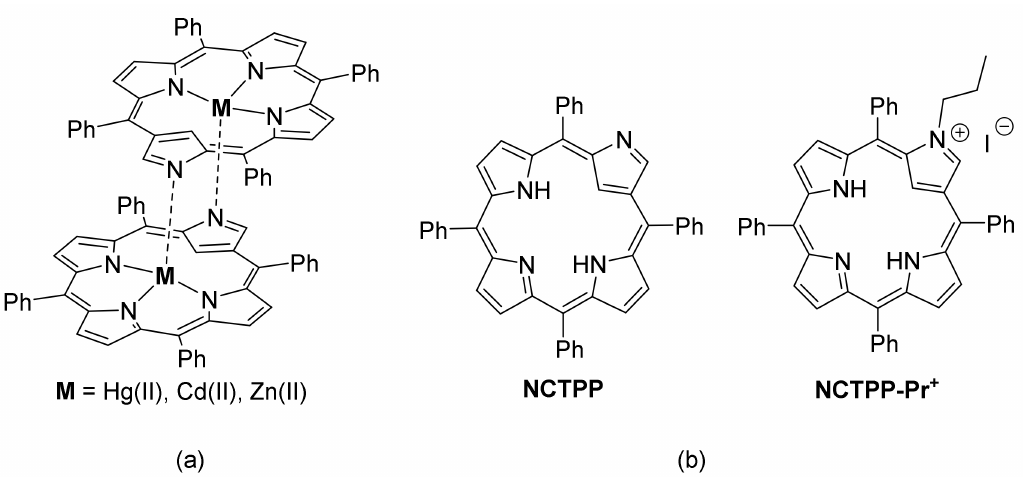
Figure 1. ( a ) Sandwich type complex of N -confused porphyrins and ( b ) Structures of NCTPP and NCTPP-Pr +